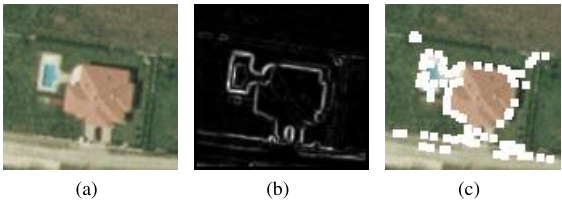
Figure 2: Operation of the modified Harris detector: (a) shows the original image; (b) is the proposed R logmax function; (c): Key- points chosen as local maxima of R logmax